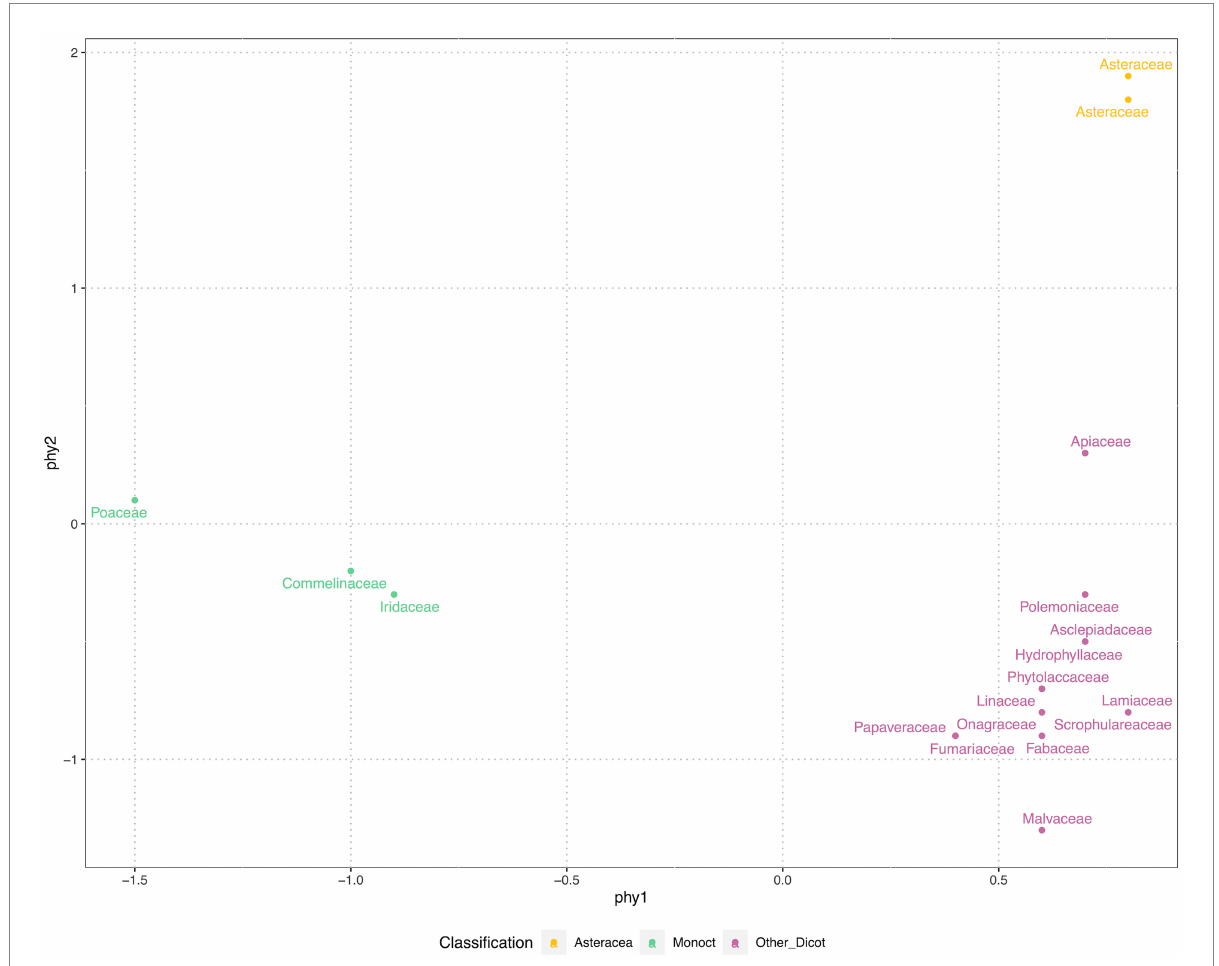
FIGURE 3 Phylogenetic position of 45 species, represented by family, were clustered in three groups. The phylogenetic positions were generated from paired-wise distances of species on the phylogenetic tree (see Figure 1). The nonmetric multidimensional scale (NMDS) was applied, at the stress of 17.86, displayed in two axes. For the convenience of display the phylogenetic positions were grouped and color coded by